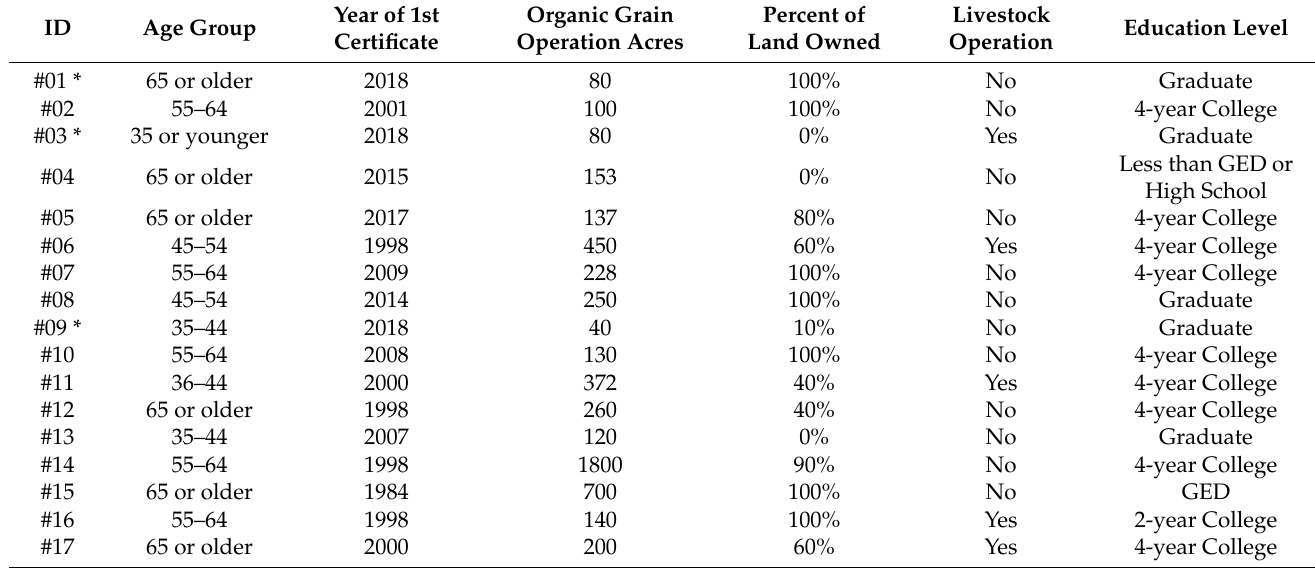
Table 1. Participant’s Demographics and Farm Structural